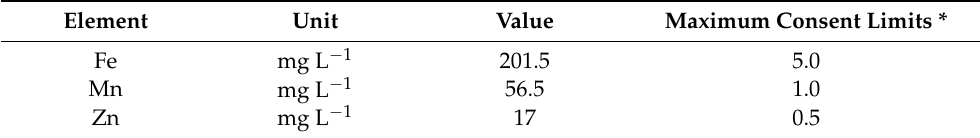
Table 2. Chemical composition of the AMD sample collected from “Rosia Montana” gold mine. Element Unit Value